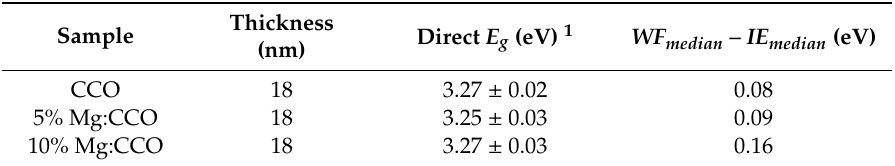
Figure 8. ( a ) Ultraviolet – visible (UV-vis) absorbance and transmission (inset) spectra and ( b ) Tauc plots and linear fits of the band edge (straight lines) for CCO (black curve), 5% Mg:CCO (red curve), and 10% Mg:CCO (blue curve) films. Table 3. Thickness and direct E g of CCO, 5% Mg:CCO, and 10% Mg:CCO films with ~0.22 absorbance at 300 nm wavelength.